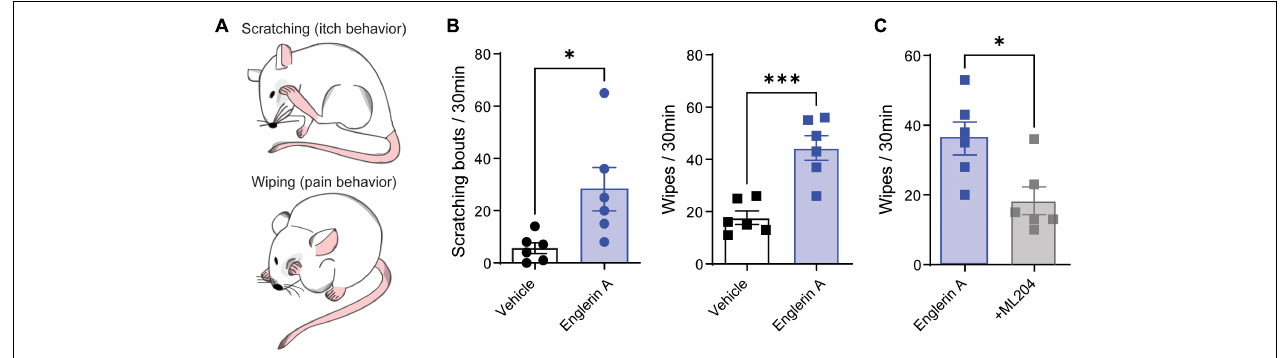
FIGURE 1 | TRPC4 activation induces both pain and itch. (A) Illustration of cheek injection model by which pruritogens elicit hind paw scratching responses and algogens evoke unilateral front paw wiping responses. (B) Treatment with Englerin A (100 µ g), a TRPC4 agonist, evokes significant increases in both scratching and wiping bouts in male mice. (C) ML204 (40 µ g), a TRPC4 antagonist, significantly attenuates Englerin A-evoked wipes. ∗ p < 0.05, ∗∗∗ p < 0.001, vs. vehicle (PBS). Two-tailed, unpaired Student’s t -test, n = 6 mice/group.